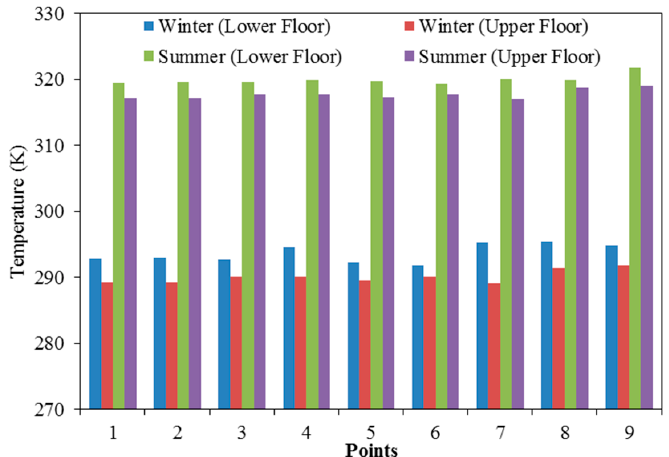
Figure 13. Comparison of the airflow velocity distribution inside the dome house during winter month of January (wind-induced flows).